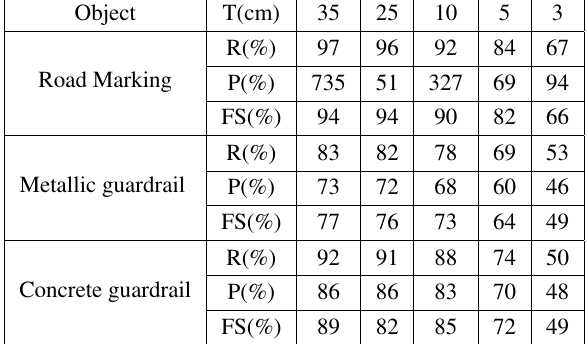
Table 5. Linear object detection and vectorization